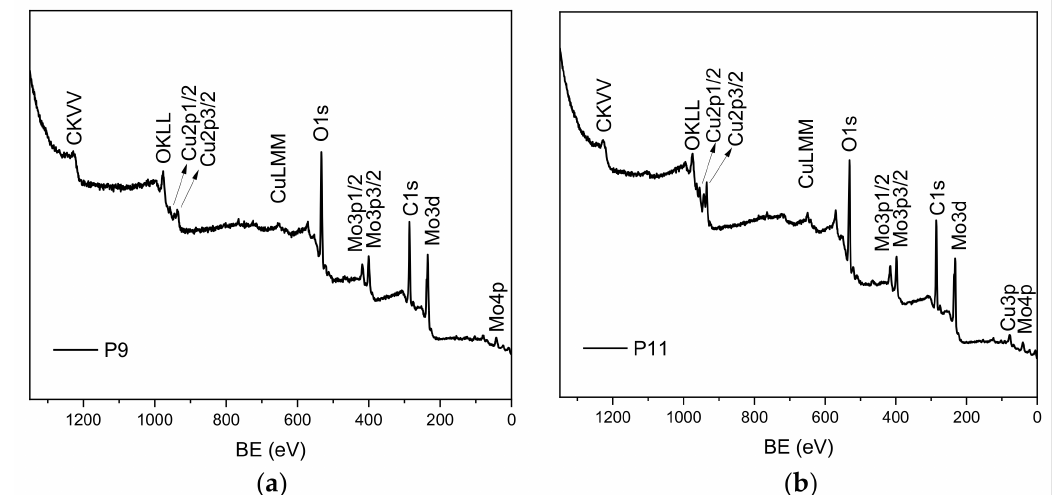
Figure 7. XPS survey analyses of sample BP_9 and sample PG_11. ( a ) XPS Sample BP_9, ( b ) XPS Sample PG_11.